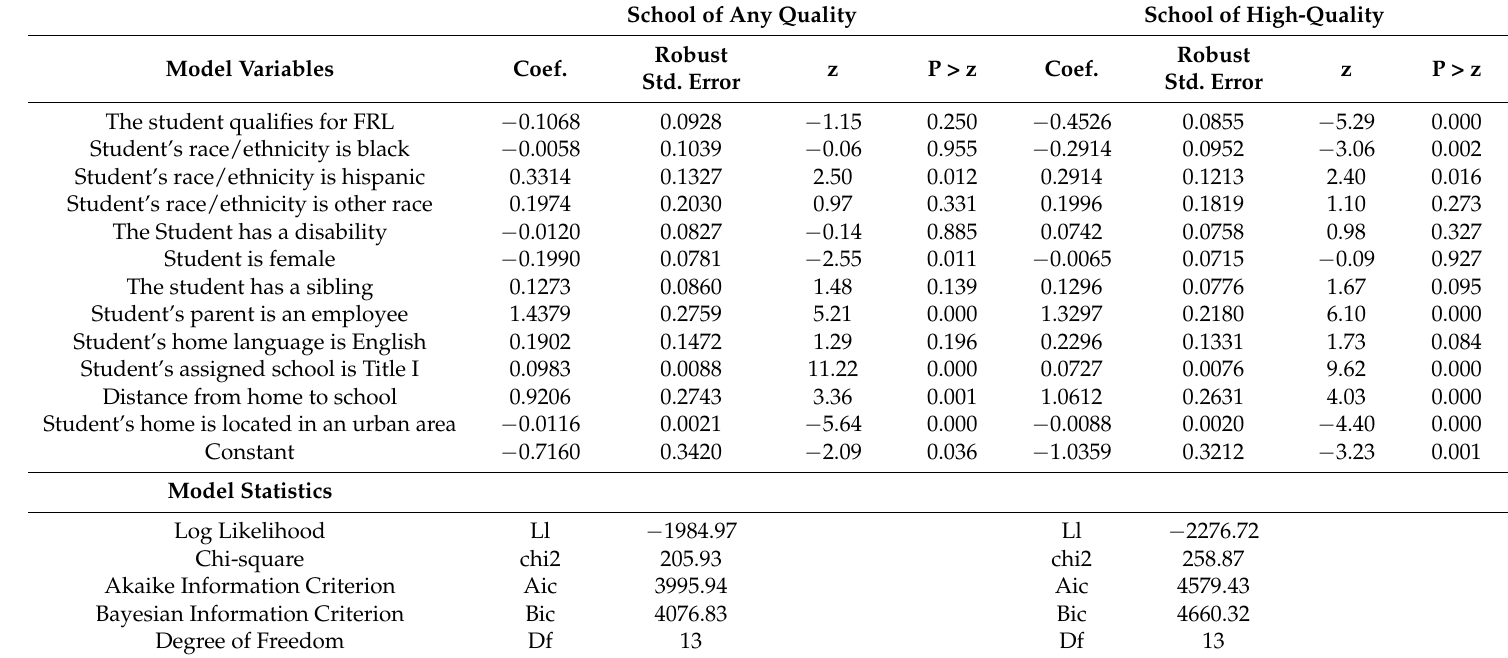
Table 5. Model estimates for the opportunity to get an offer to an SDHC magnet middle